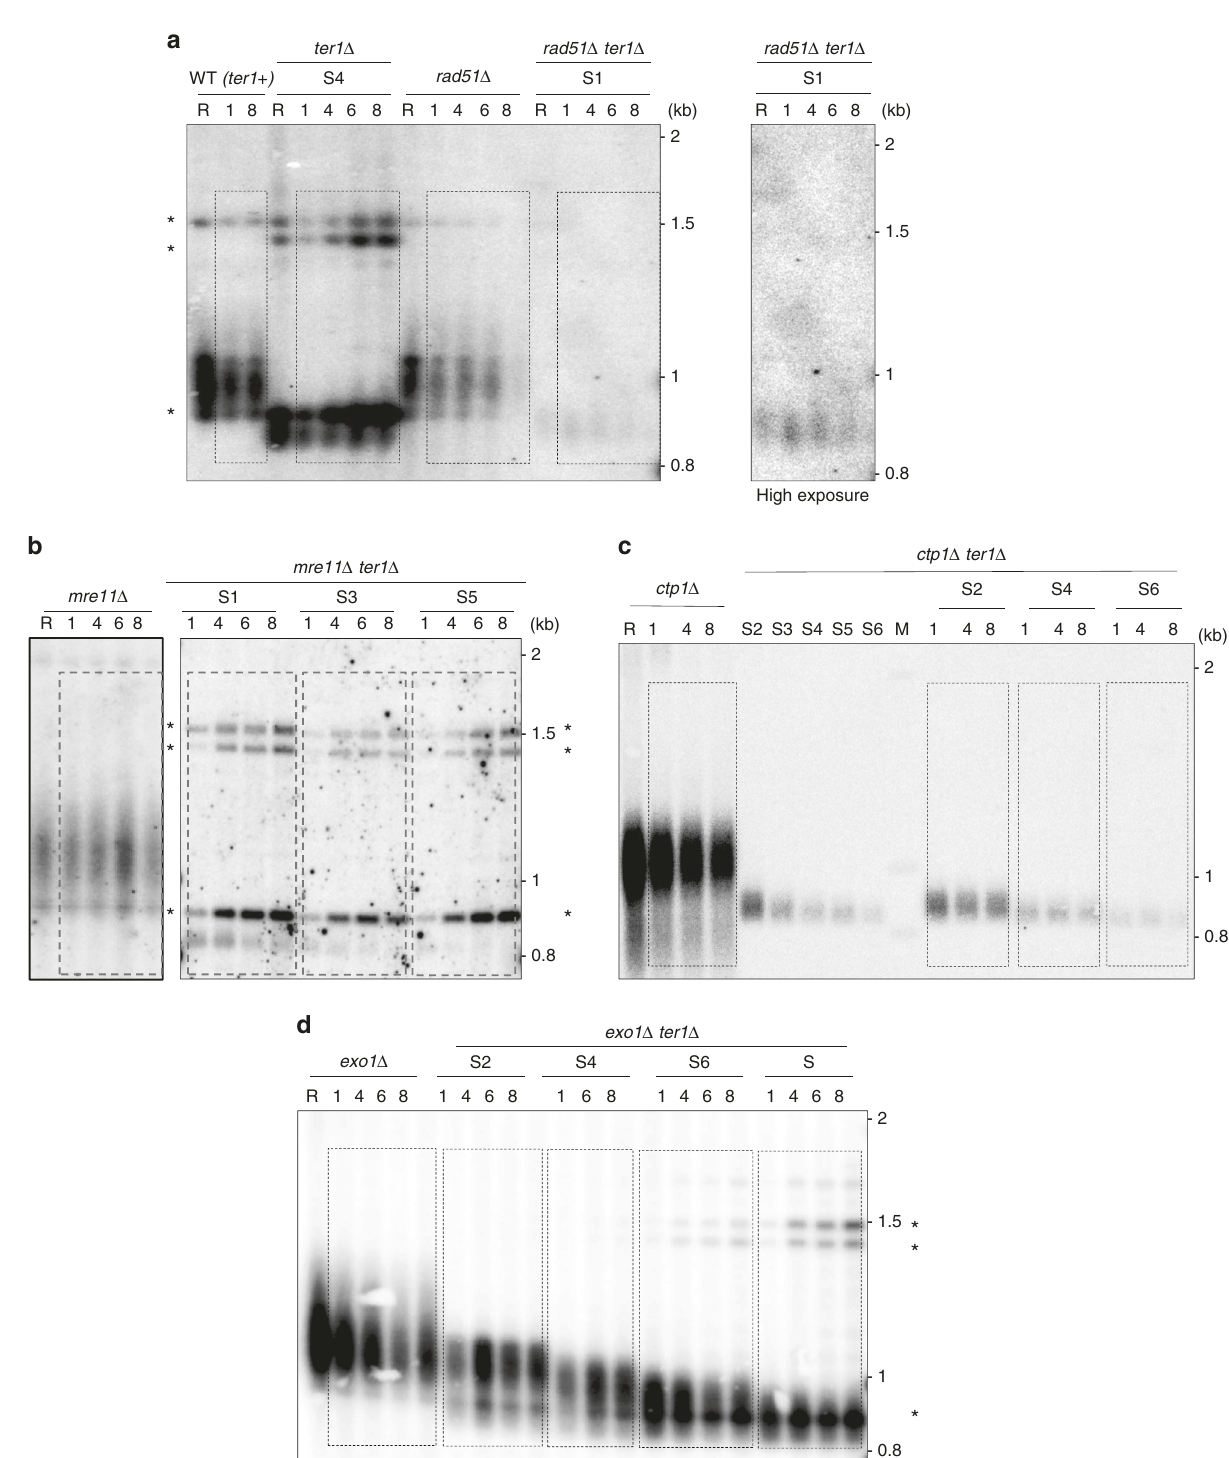
Fig. 4 STEEx rearrangements in quiescent cells depend on Rad51 and Ctp1 but not on Mre11 or Exo1. a – d Telomere structure during quiescence of the indicated mutants. Genomic DNAs from single or double mutants were digested with EcoR I and analyzed by southern blot with a Telo/STE1 probe. ter1 + cells and ter1 Δ cells that were collected at different days during replicative senescence (S1 – S8) and shifted to deprived-nitrogen medium. Cells were collected after the indicated days (1, 4, 6, and 8) in quiescence. R shows ter1 + cells collected during replicative growth and M correspond to molecular weight markers. STEEx are shown by the nat r :Pnmt1 cassette (tiSTEEx) (Fig. 3d). At day 8 of G0, a STEEx) (Fig. 3d, e). These data show that duplication of smear was clearly detected with the nmt1 probe, re fl ecting subtelomeric sequences primarily occurs internally in cis and rearrangements between tiTel and natural telomeres (ti/natural- then propagates to other chromosome extremities.